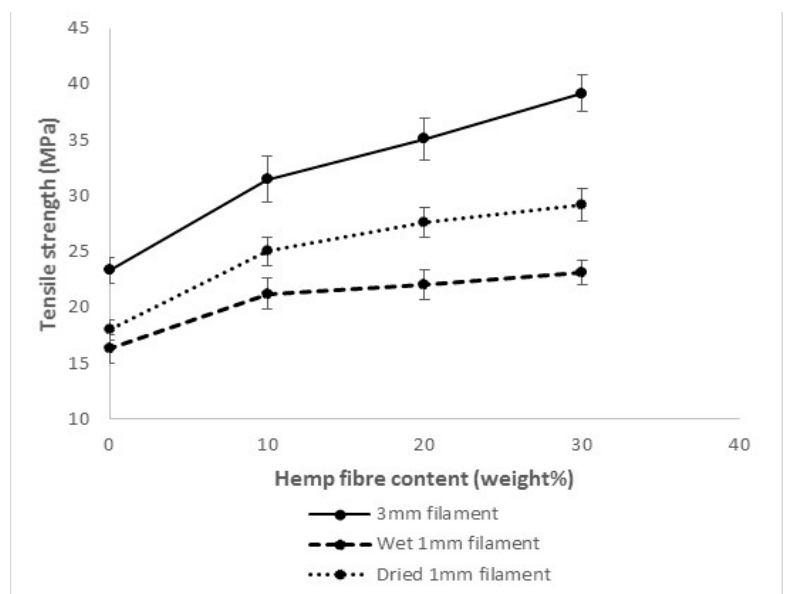
Figure 9. Tensile strength comparison between hemp reinforced 3 mm, 1 mm wet and 1 mm dry filaments.